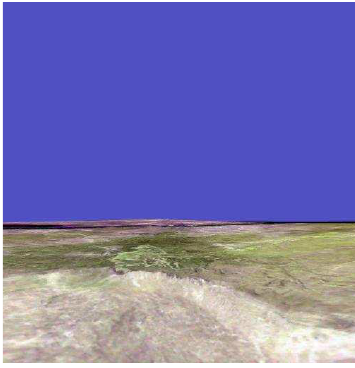
Figure 12. 3D scene of mosaic of Landsat-4 MSS images 172/35 and 36 taken 12.7.1983, channels 574 from south to north at Tar al-Sbai. Constructed by M. Törmä 2006.